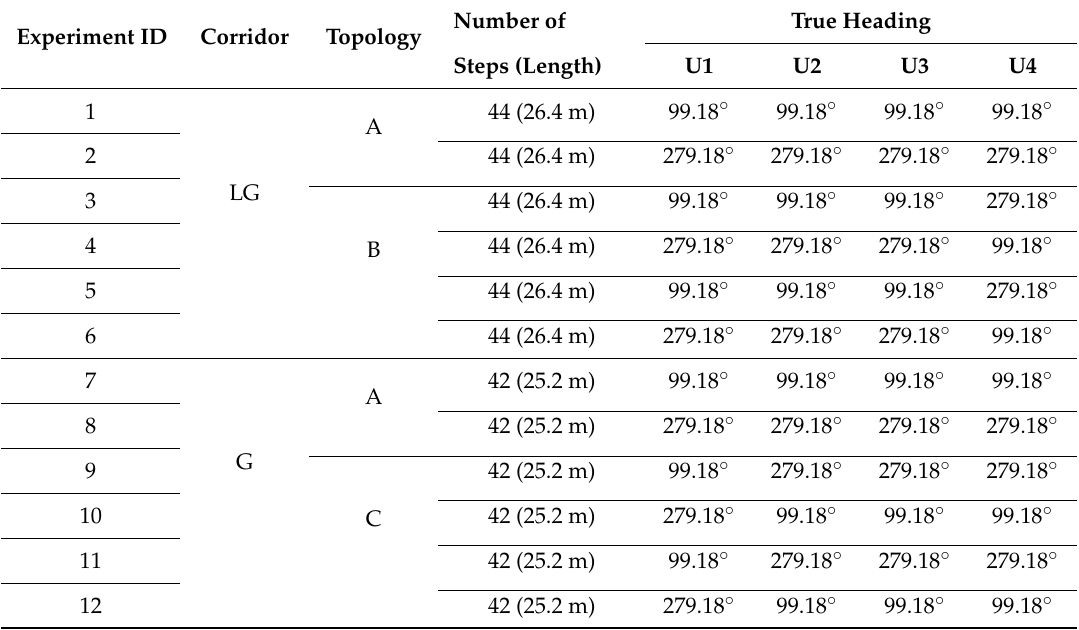
Table 1. Small-Scale Scenario